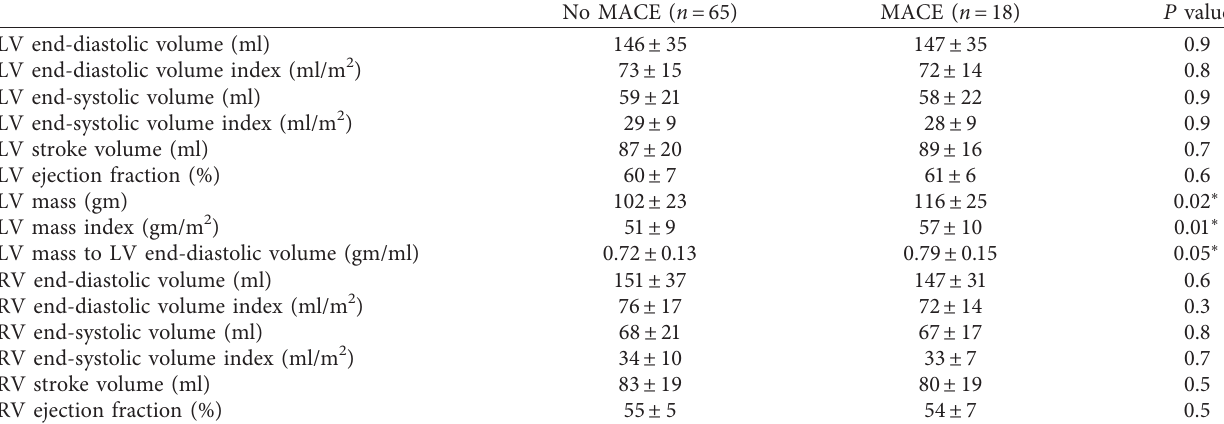
Table 5: CMR findings at baseline of the participants with and without MACE (angina, myocardial infarction, revascularization, and cerebrovascular accident) at